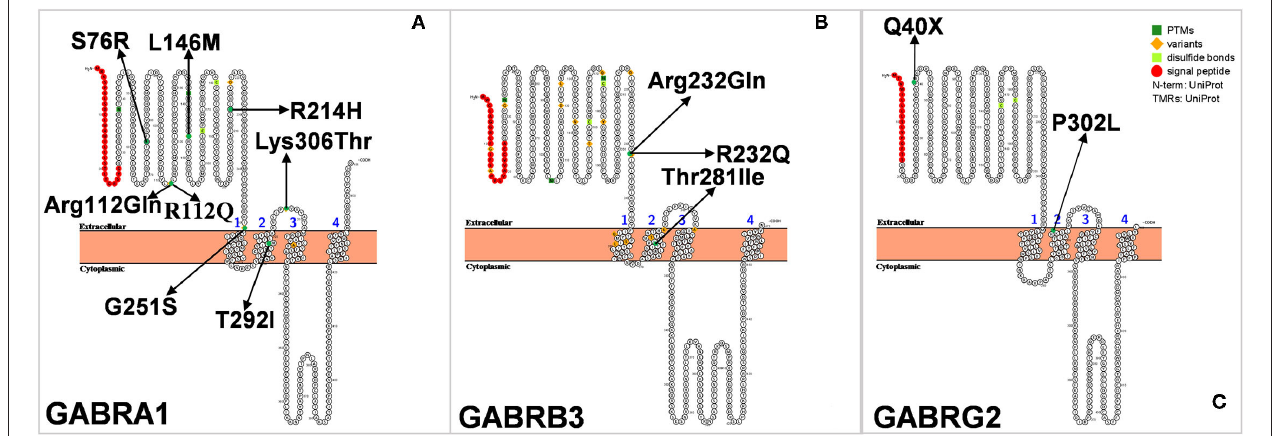
FIGURE 6 | (A–C) Schematic diagram of protein encoded by GABRA1 , GABRB3 , and GABRG2 , illustrating the location of the amino acids affected by the mutations identified in patients.